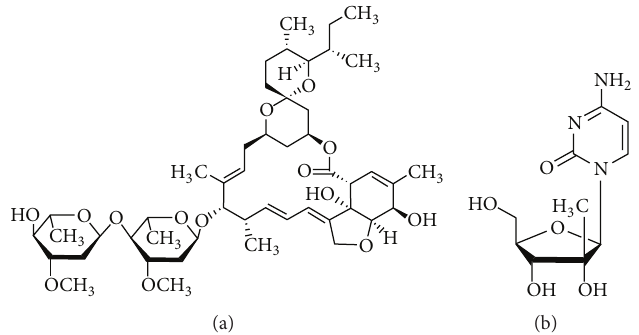
Figure 1: Chemical structure of ivermectin (a) and 2 󸀠 -c-methylcytidine (b).